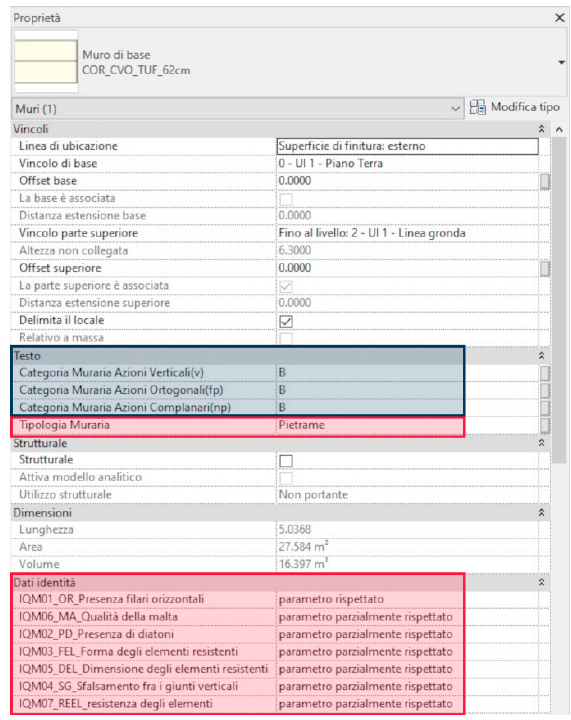
Figure 14. Properties of a wall in the IQM Revit Template, with the IQM parameters (input—red) filled in by the IQM operator and the automatically returned IQM category values (output—blue),